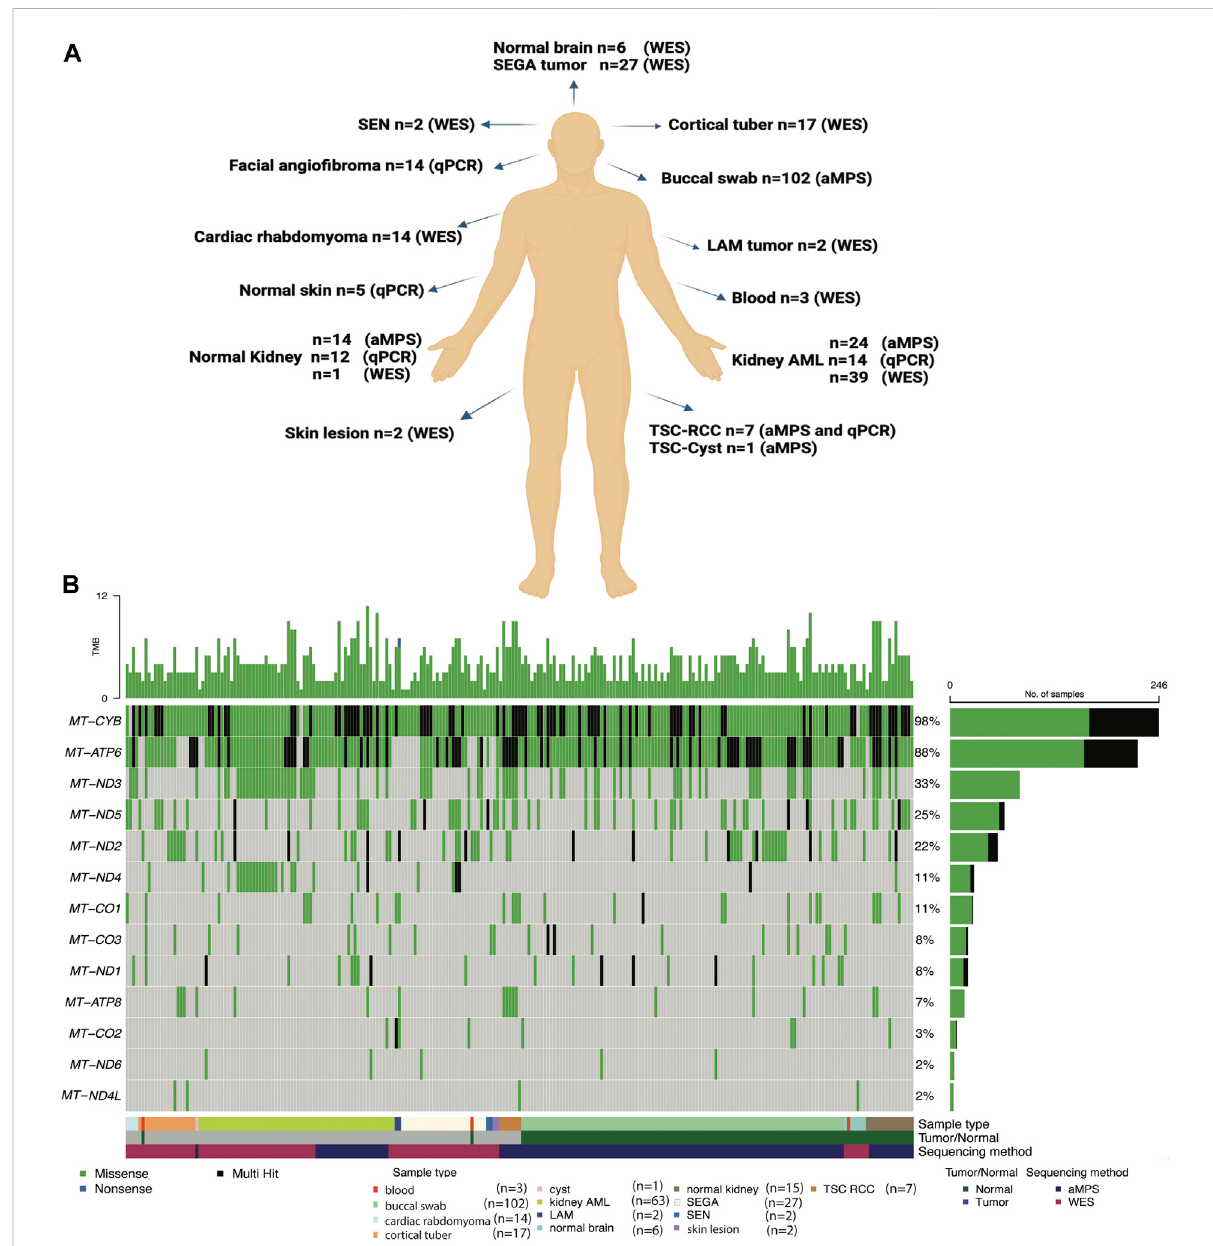
FIGURE 1 Summary of the TSC samples analyzed, mtDNA analysis methods implemented, and the most common mtDNA variants identi fi ed. (A) Comprehensive mtDNA analysis was performed in 270 samples (139 tumors and 131 non-tumor tissues) from 199 patients with TSC and 6 healthy controls. The non-tumor tissue samples include 102 buccal swabs. mtDNA was sequenced using amplicon-based massively parallel sequencing (aMPS)andoff-targetextractedmtDNAreadsfromwhole-exomesequencing(WES)analysis.WealsoperformedmtDNA/gDNAqPCRtoassess mitochondrial content. Figure was prepared from a template in Biorender. (B) Annotation of the types of mtDNA variants discovered in the 13 protein-coding genes of the mitochondrial electron transport chain in TSC-associated tumors (n = 125) compared to unaffected tissues (n = 126) from 191 patients with TSC and 6 healthy controls. The type of tissue (normal or tumor) and method of mtDNA sequencing is indicated. Missense variants(green),non-sense(blue),andgeneswithmultiplevariantsidenti fi edinasinglecodinggene( “ multi-hit ” ,black)areindicatedinTSCtumorsof the skin, blood, kidney, and brain, as well as buccal swabs and normal adjacent